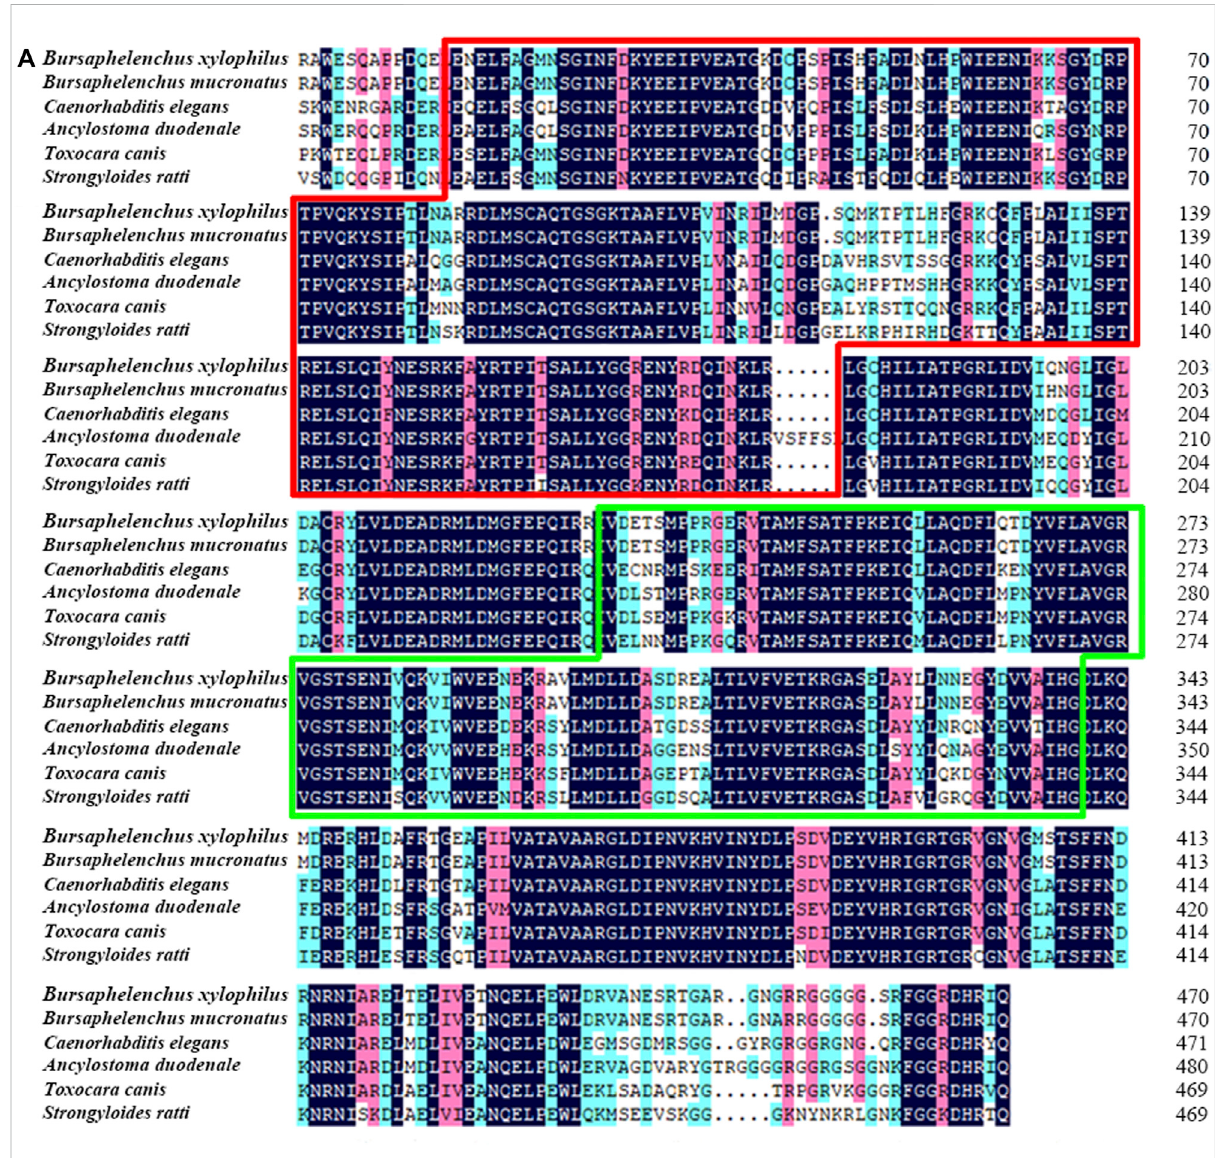
FIGURE 1 Sequence analysis of Bxy-laf-1. (A) Multiple amino acid sequence alignments. B. xylophilus (CAD5234552.1), B. mucronatus (OM210018), Caenorhabditis elegans (NP 001254859.1), Ancylostoma duodenale (KIH65785.1), Toxocara canis (KHN84719.1) and Strongyloides ratti (XP 024501163.1).Black,redandblueshadingindicatesinvariant,highlyconservedandmoderatelyconservedaminoacidresidues,respectively.Thetwo conserved DNA-binding motifs of LAF-1, DEAD and Helicase C, are enclosed by the red and green boxes, respectively.